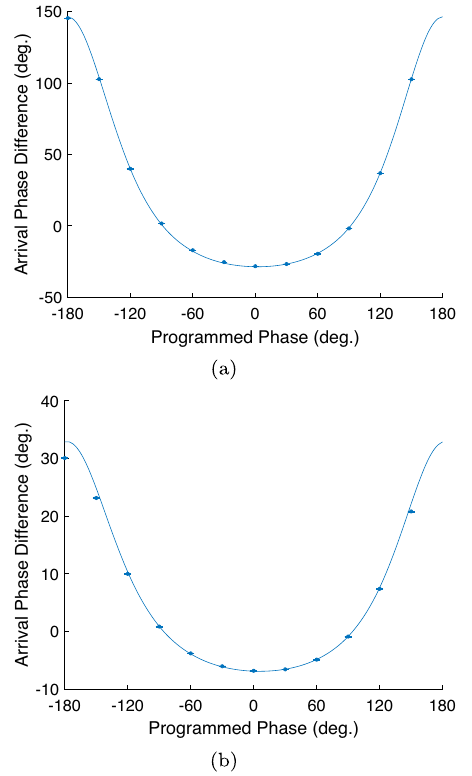
FIG. 2. BPM arrival phase difference measurements used for calibrating the phase offset for the first (a) and last linac cavity (b). Solid line shows the best fit of the data to the MLC phasing